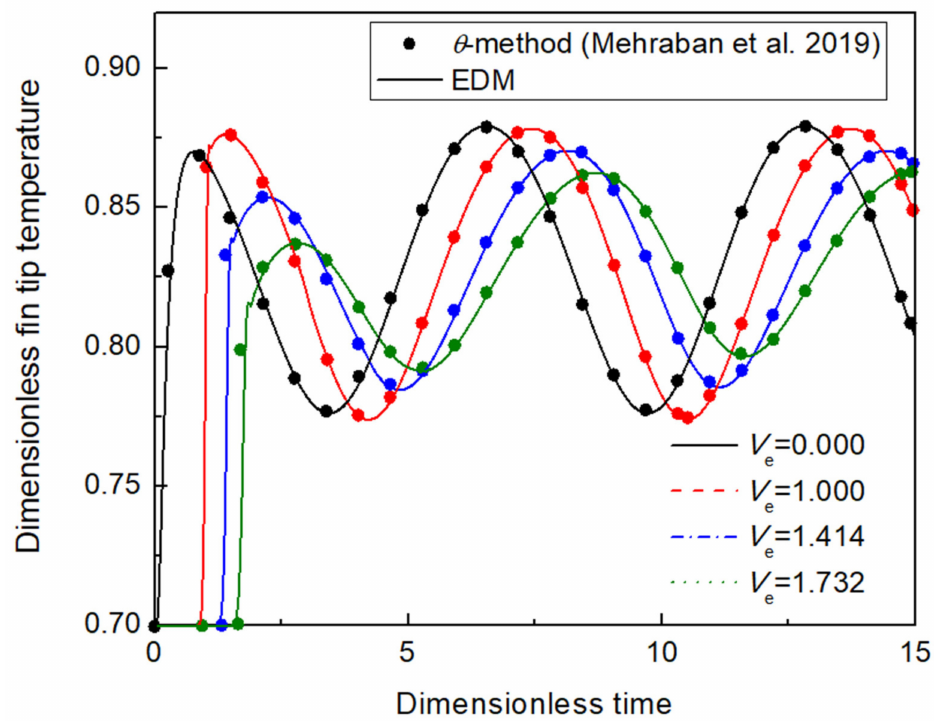
Figure 4. Comparison of dimensionless fin tip temperature by the EDM and the θ method